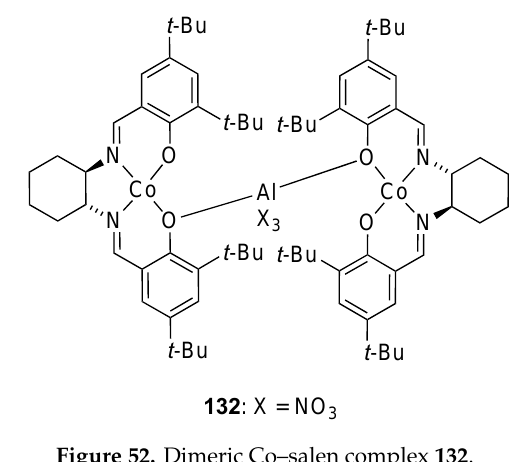
Figure 52. Dimeric Co–salen complex 132 .